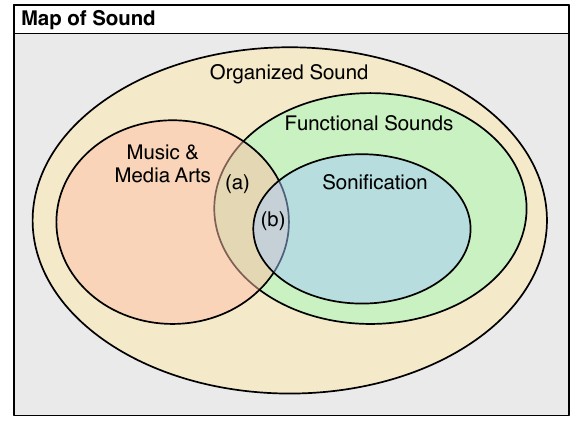
Figure 3: Systemic map of sound, showing sonification and its relation to other